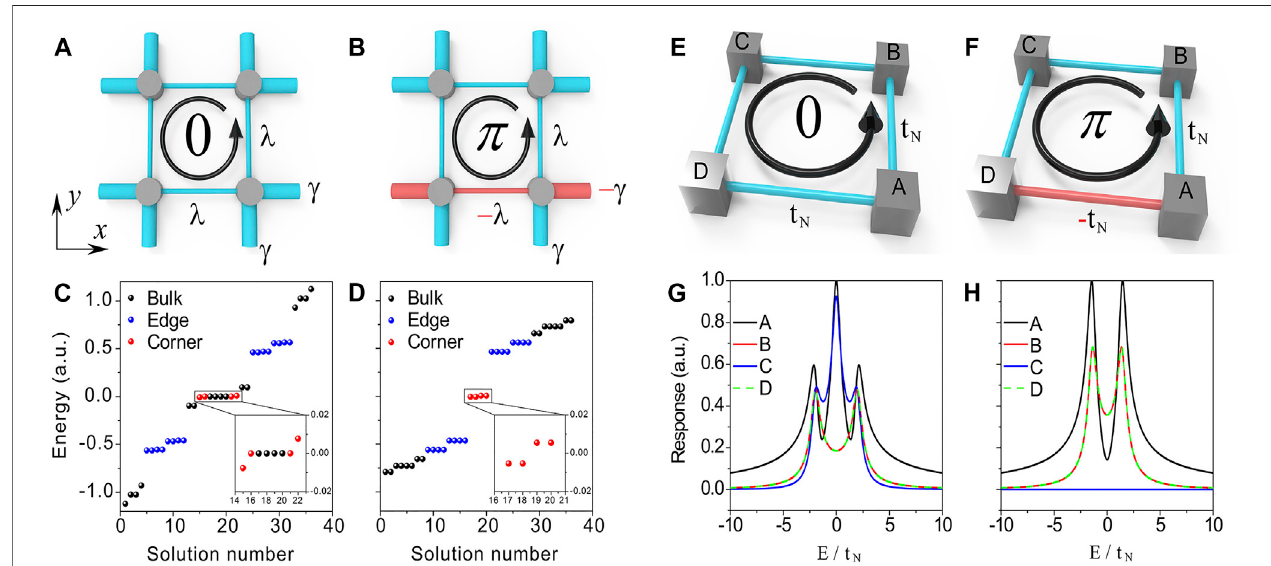
FIGURE1| TheunitcelloftheTDI (A) andTQI (B) ,wherethethinandthicktubesdenotetheintracell( λ or − λ )andintercell( c or − c )hopping,respectively. (C – D) The bulk(blackpoints),edge(bluepoints),andcorner(redpoints)modesofa3 × 3latticeoftheTDI (C) andTQI (D) ,where λ (cid:2) 0 . 1and c (cid:2) 0 . 5. (E – F) Schematicdrawingsof a corner-mode Hamiltonian for the TCMs of the TDI (E) and TQI (F) . The gray boxes represent the TCMs. The blue and red tubes respectively represent positive and negative edge hopping. (G – H) The corner responses with excitation at corner A. Here, η (cid:2) 0 . 4.